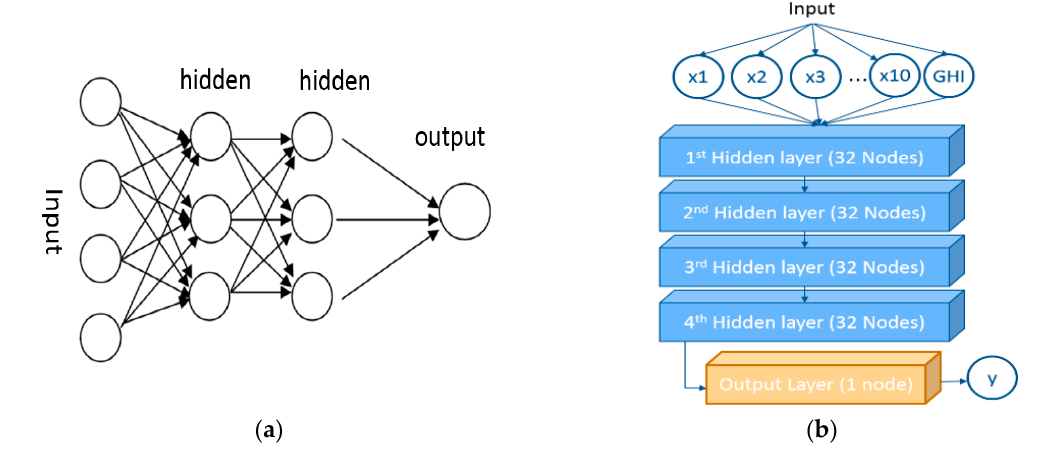
Figure 6. FFNN model: ( a ) an example of FFNN; ( b ) our FFNN model.